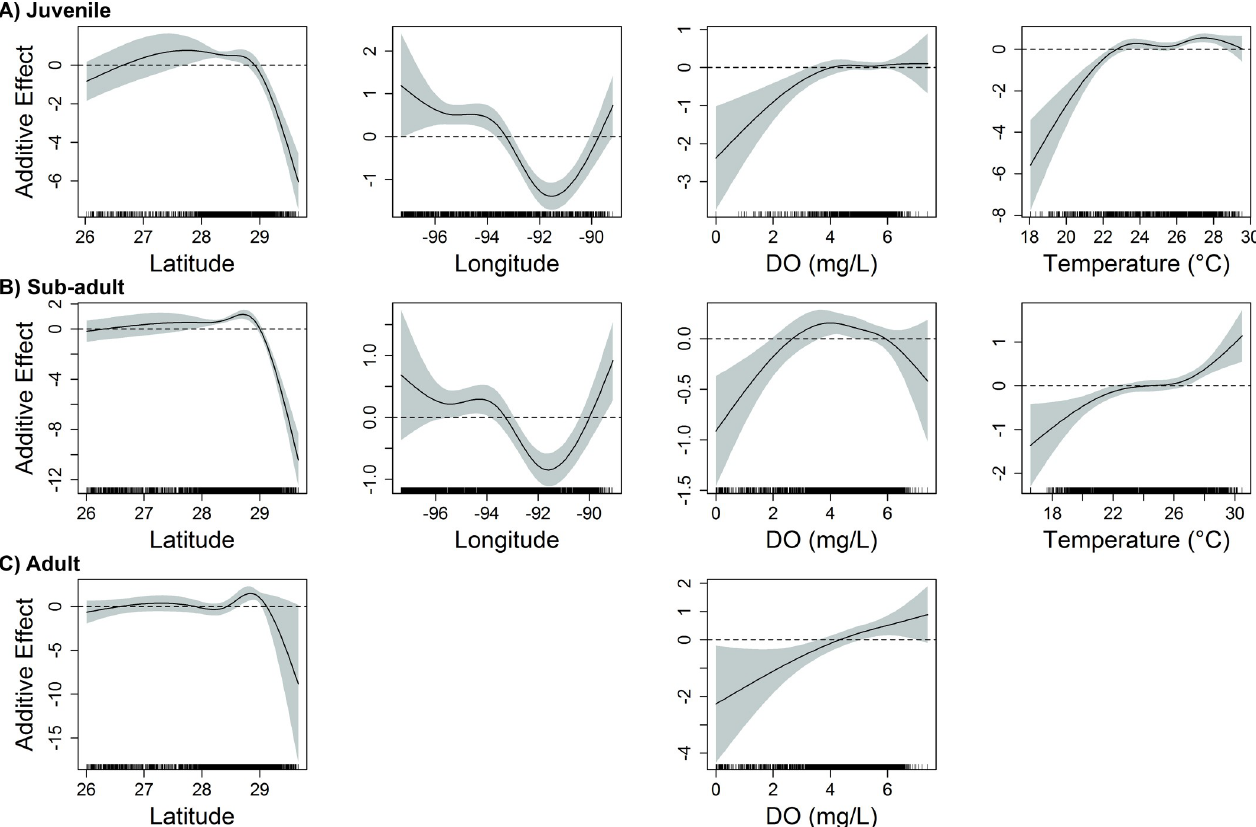
Fig 4. Influence of geographic and physicochemical variables on red snapper abundance in the western GoM. Response plots from final generalized additive models show the influence of latitude, longitude, bottom dissolved oxygen (DO), and bottom temperature on the abundance of A) juvenile (age-0), B) sub-adult (age-1-2), and C) adult (age-2+) red snapper over unconsolidated bottom in the western GoM. Solid lines represent smoothed values, and shaded areas represent 95% confidence intervals. Dashed lines are included at y = 0.